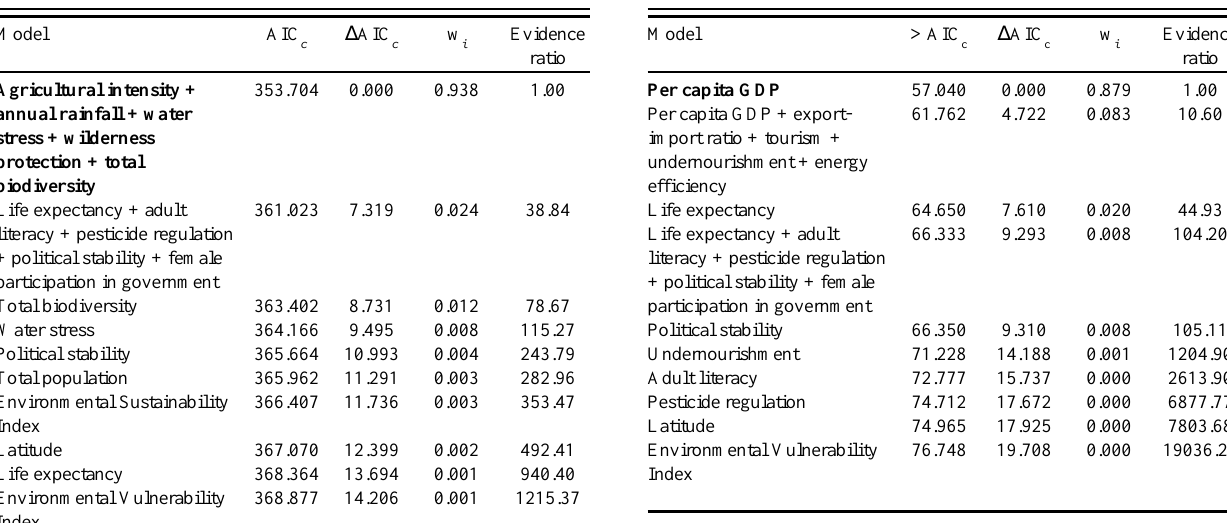
Table 5 . A comparison of support for the top 10 models of social-ecological factors and the proportion of invasive birds in 100 different countries. Models were ranked by Akaike’s information criteria (AIC), and parameter abbreviations are as follows: D AIC is the difference between AIC values from c c each model, and w is the Akaike weight. Bold values indicate i variables in the best model.